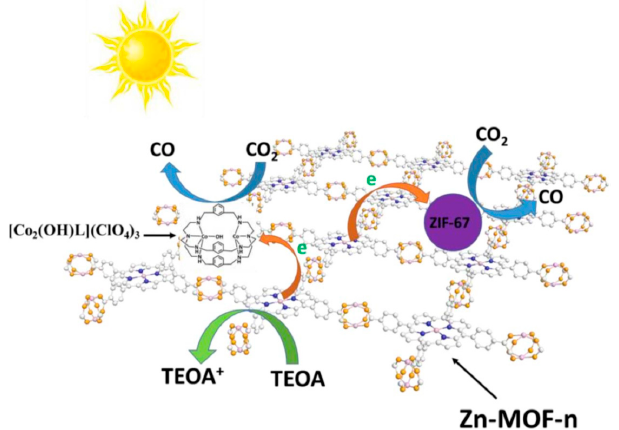
Figure 11. A MOF/Co-complex or MOF/ZIF-67 system for CO 2 photoreduction with Zn-MOF nanosheets as the photosensitizer and Co-based materials as photocatalysts (Reprinted with permission [148]. Copyright 2018 Elsevier).